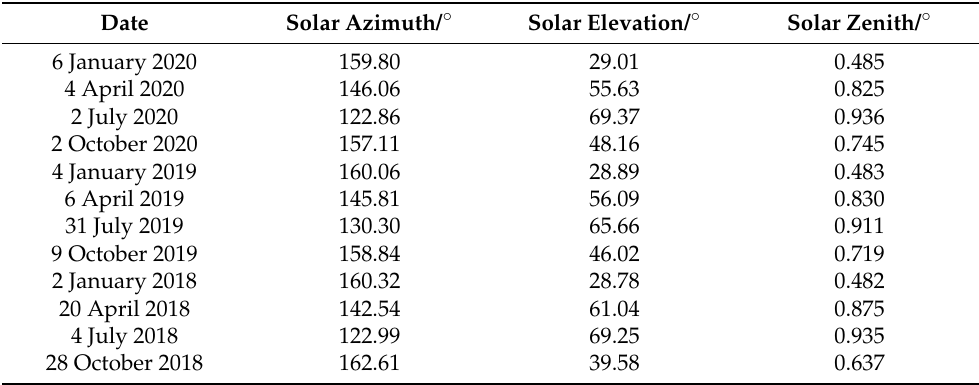
Table 1. Datasets of the Himawari ‐ 8 AHI image angle profile.